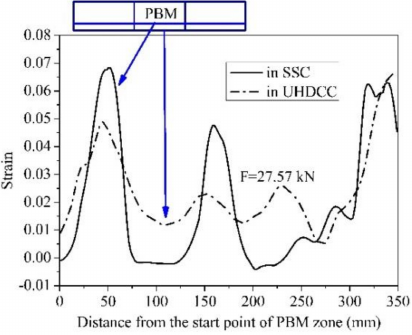
Figure 18. Strain distributions in x direction (in